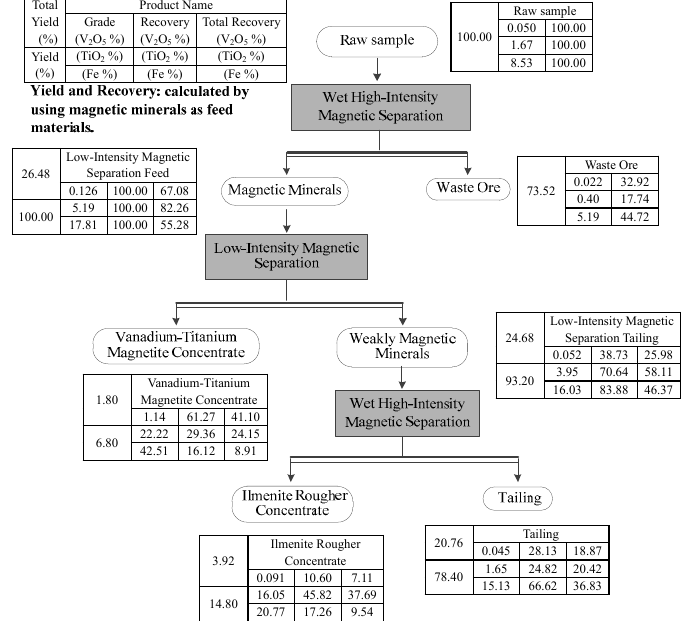
Figure 8. Flow-sheet for the pre-concentration of low-grade vanadium-titanium magnetite ore.